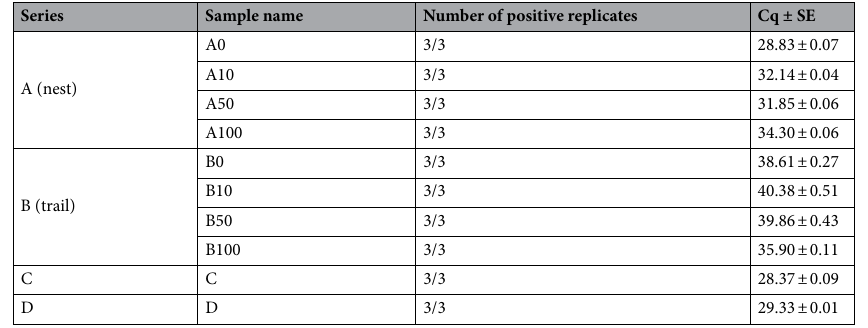
Table 4. Real-time PCR results for Port Island October 2017. The column “Cq” shows the average Cq values among the three replicates in real-time PCR. The numbers in each sample name in series A and B represent the distance (cm) from the nest or trail. Sample C was from a pile beside a L. humile nest, and sample D was soil at the site where L. humile was not found. The raw data are listed in Table S5.